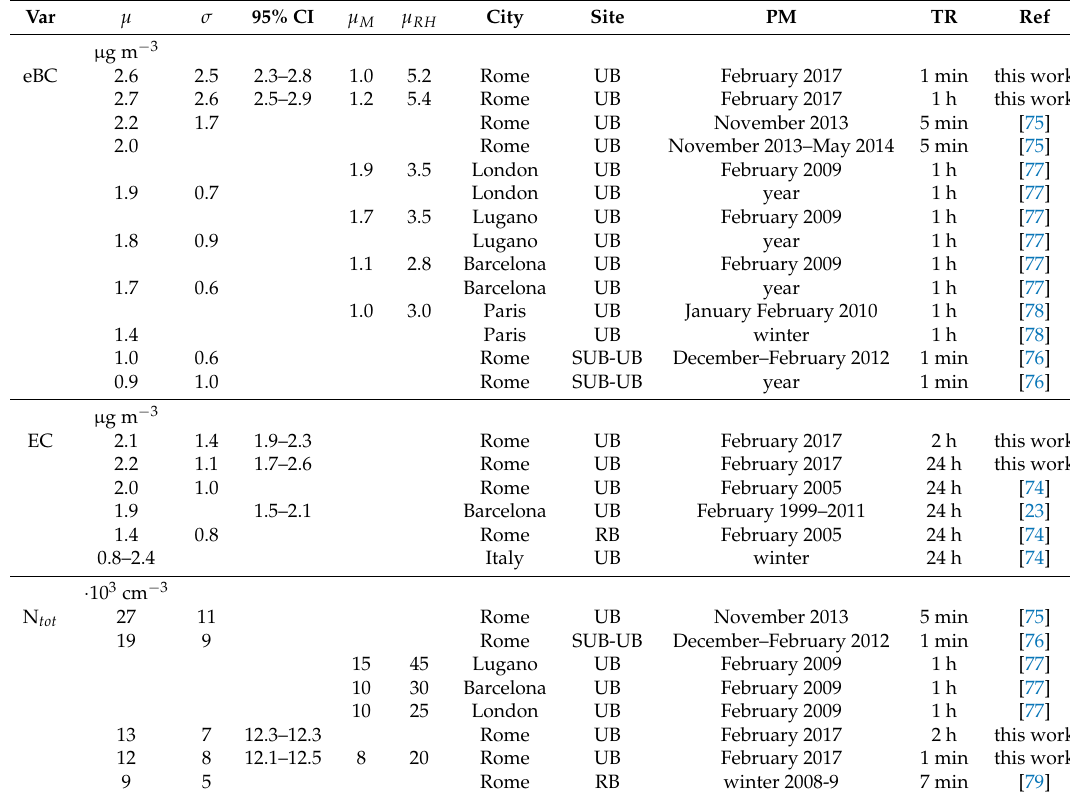
Table 7. Comparison between value measured in Rome and across other European cities. Mean ( µ ), standard deviation ( σ ), 95% C.I. of mean (95% CI), mean value at midday ( µ M ), mean value at the rush hour ( µ RH ), site representativeness (UB = urban background, SUB-UB = suburban background, RB = regional background), period of measurements (PM), time resolution of data used to calculate the statistics (TR), and references. The eBC data in this work are from MAAP (Table 2 and 3); eBC in Paris, Barcelona and Lugano were taken by Multi Angle Absorption Photometer (MAAP), in London by Aethalometer AE-21.